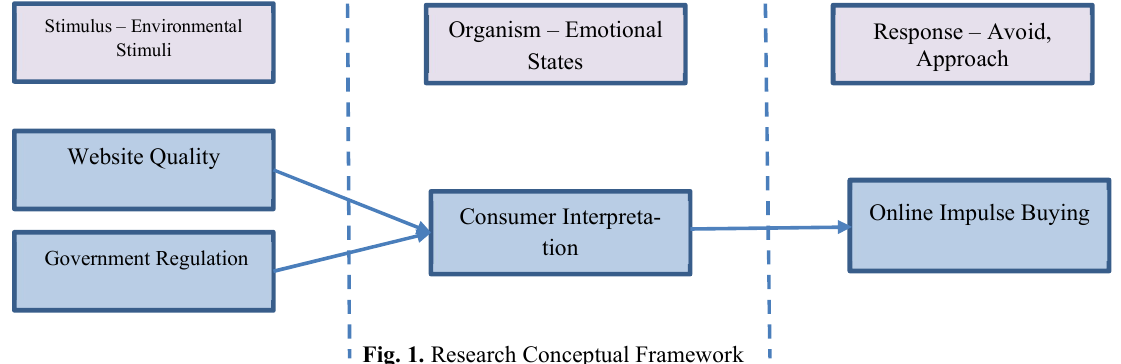
Fig. 1. Research Conceptual